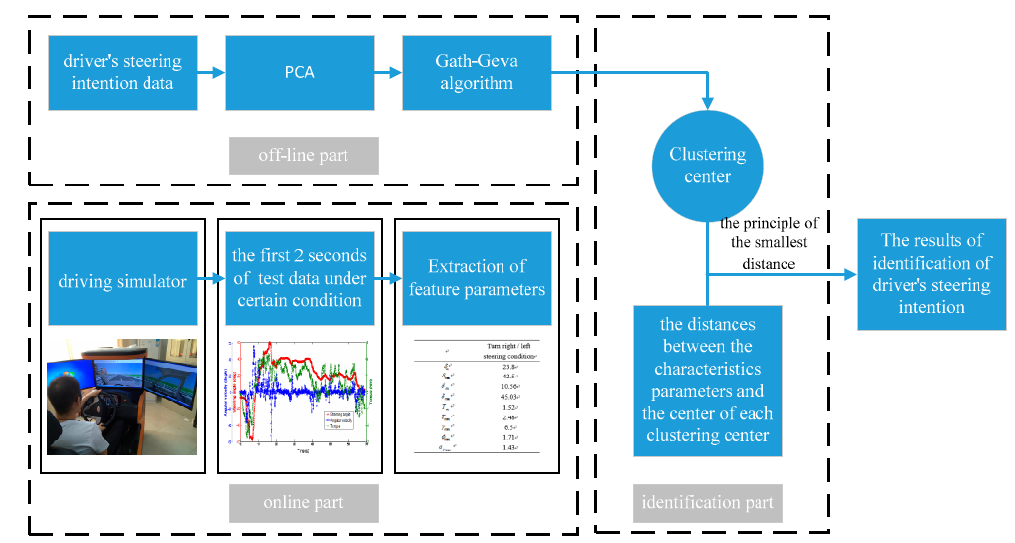
Figure 14. The flowchart for the identification of the driver’s steering intention. PCA: Principal Component Analysis.